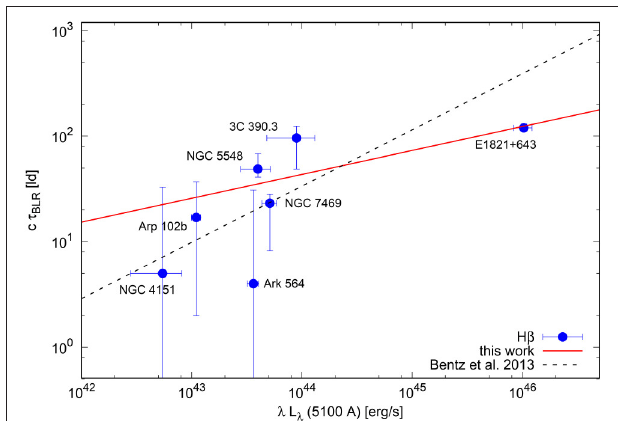
FIGURE 4 | The radius of the broad H β line emitting-region vs. the continuum luminosity at 5100 Å. The dashed line gives the BLR radius-luminosity scaling relation from Bentz et al. (2013) with R BLR ∼ L 0.533 , whereas the solid line is the fit through seven objects from this study, with R BLR ∼ L 0.226 . We note that the fit is strongly influenced from the one point, the luminous quasar E1821 + 643, and without that point the relation is consistent with the Bentz et al. (2013)